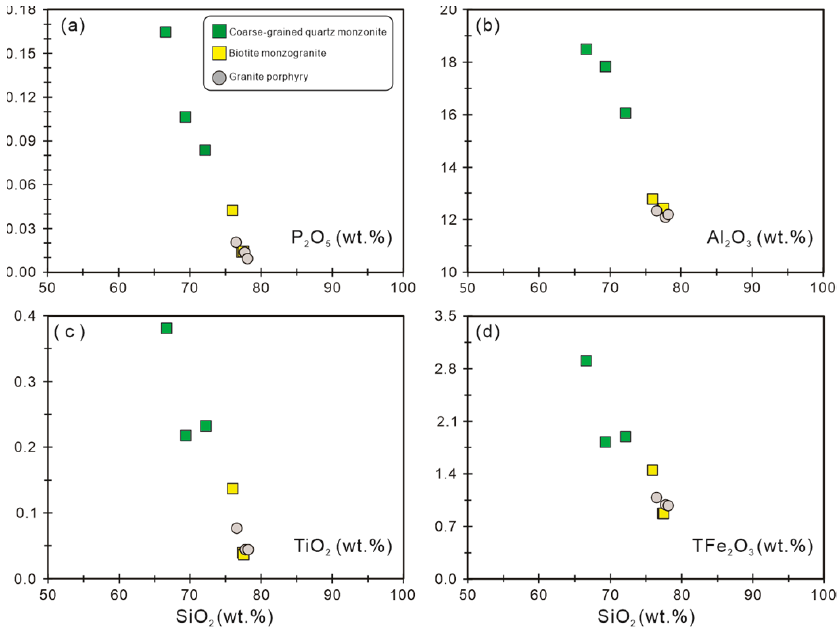
Figure 6. Diagrams of SiO 2 versus ( a ) P 2 O 5 , ( b ) Al 2 O 3 , ( c ) TiO 2 , and ( d ) TFe 2 O 3 for the coarse-grained quartz monzonite, biotite monzogranite, and granite porphyry samples from the Yushulinzi pluton in the Liaodong Peninsula.